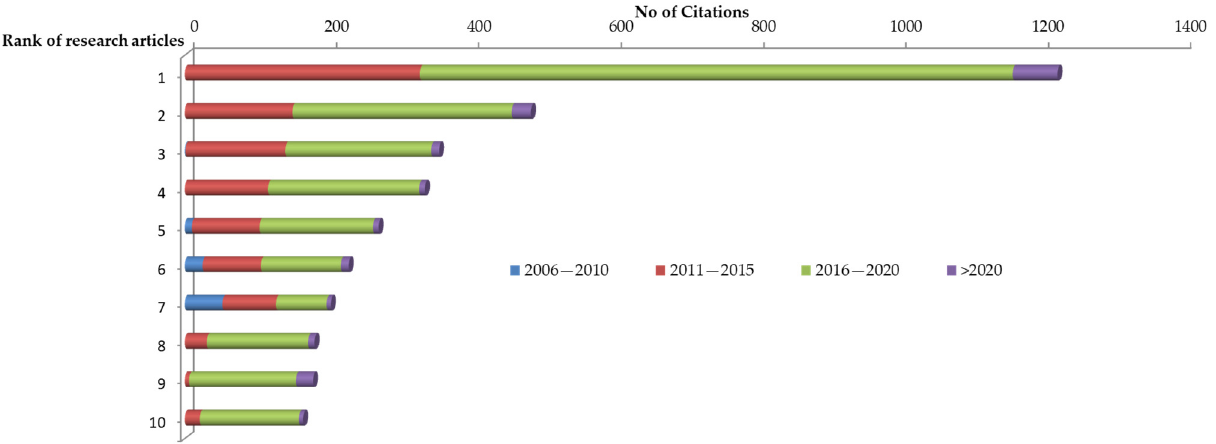
Figure 6. Distribution of total citations over four time periods for the 10 most cited articles.